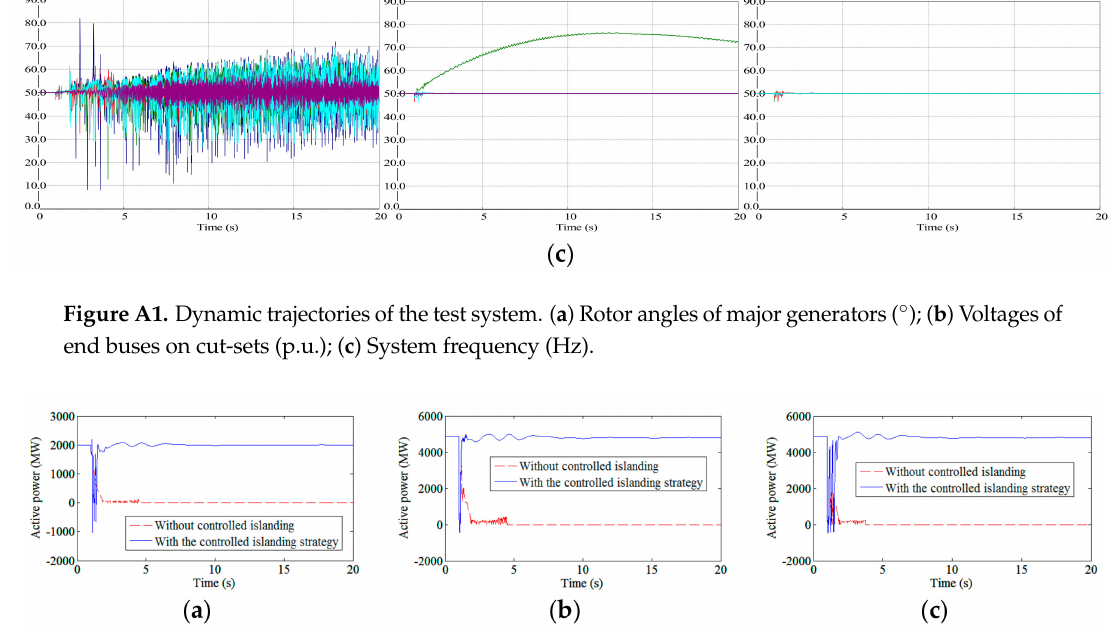
Figure A2. DC power on HVDC lines. ( a ) HVDC Line 1; ( b ). HVDC Line 2; ( c ) HVDC Line 3. Dynamics of the test system are shown in Figures A3 and A4, which is under the scenario that the three-phase short circuit occurs on Line 3 in Area 2.